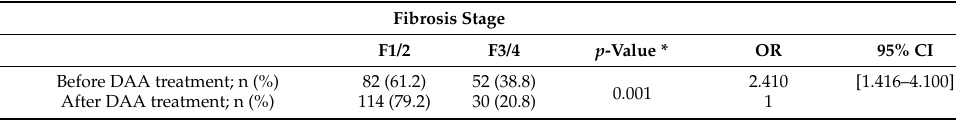
Table 4. Fibrosis stage before and after DAA